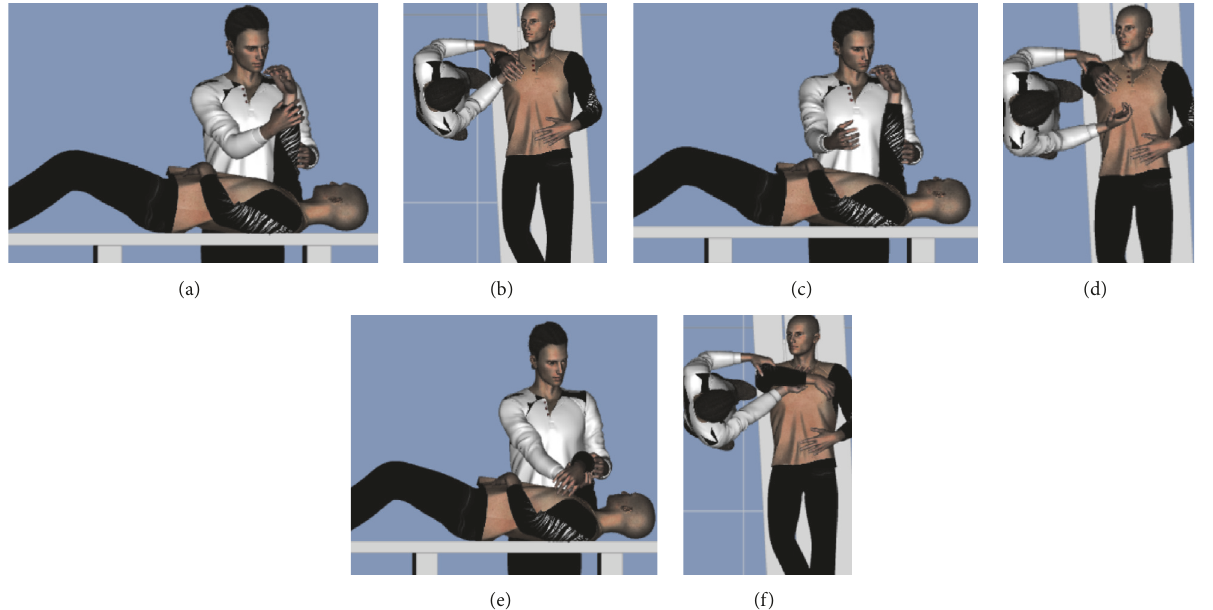
Figure 1: Patient was in supine lying position. (a, b) The affected shoulder was flexed (90 ∘ ), internally rotated and supported manually by the clinician. The patient turned the head toward the affected side. The affected elbow was passively extended and the forearm was pronated. (c, d) Patient asked to hold the elbow fully extended. (e, f) The elbow was passively flexed and the patients were instructed to actively extend it up with a leading resistance when possible followed by eccentric elbow extension with holding at different ranges ((a, c, e) lateral view and (b, d, f) superior